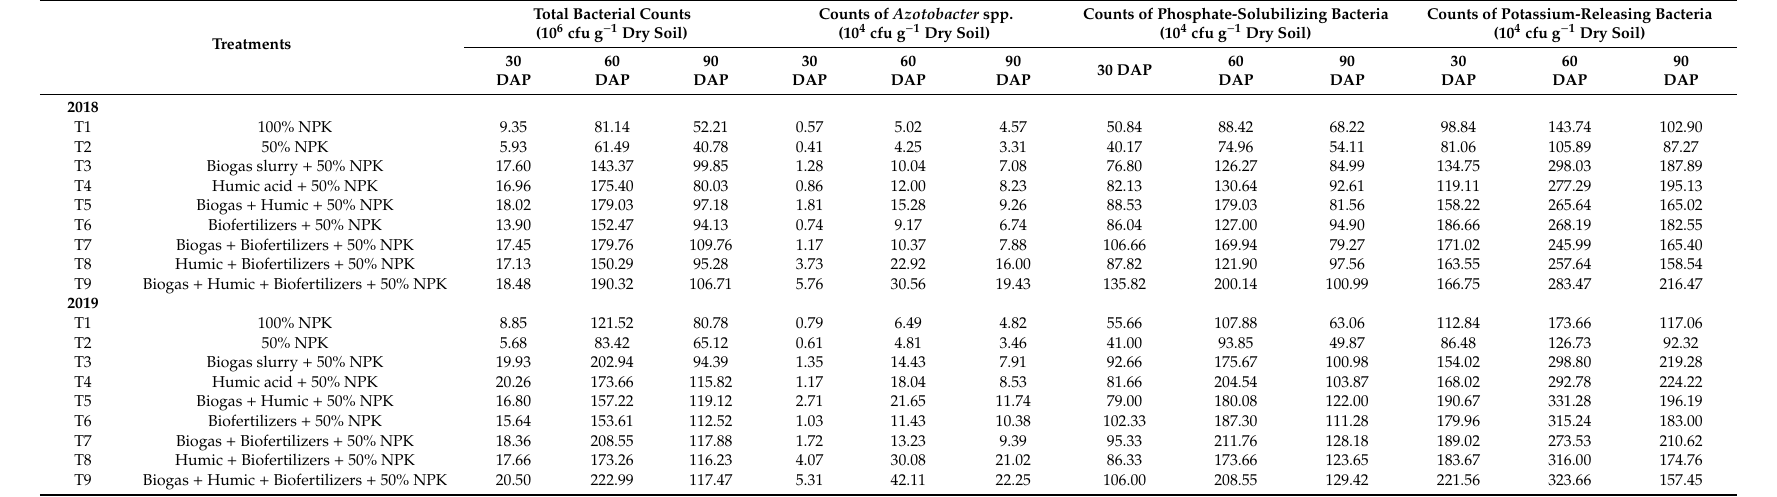
Table 7. Bacterial counts in the root rhizosphere of maize treated with organic and biofertilizers alone or in combination.